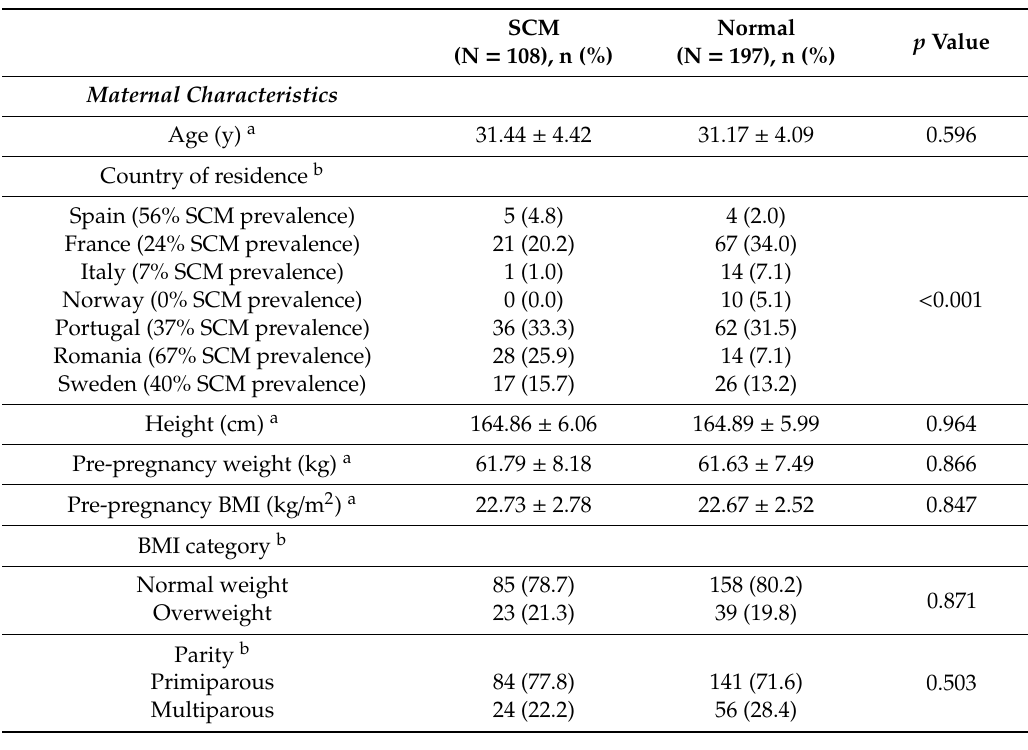
Table 1. Maternal and infant characteristics by presence or absence of SCM.